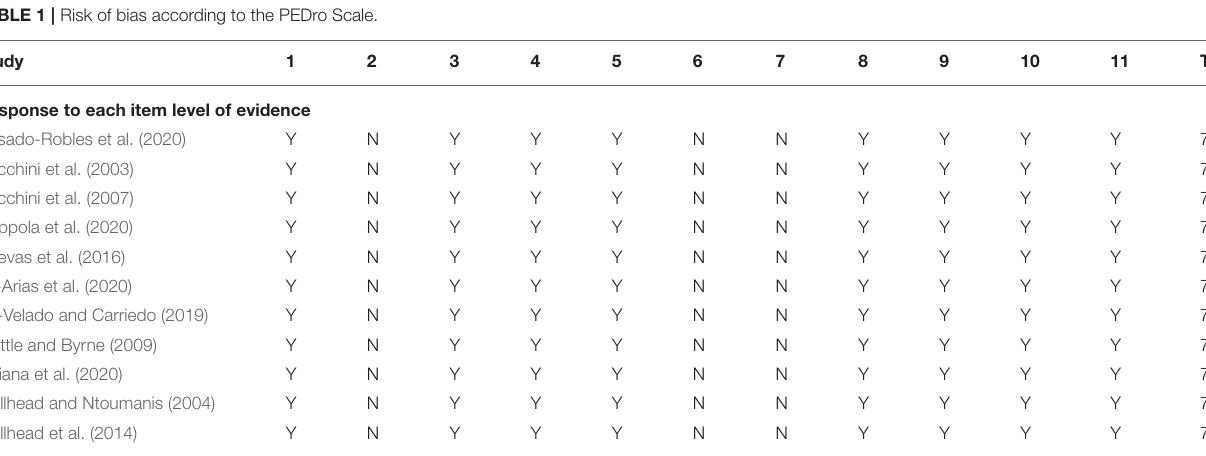
TABLE 1 | Risk of bias according to the PEDro